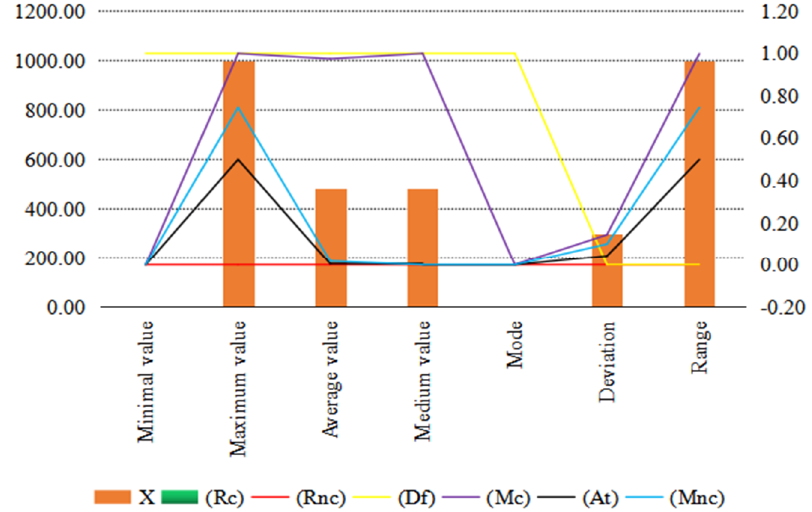
Figure 9. Analyses of when all rational nodes choose defender strategies.